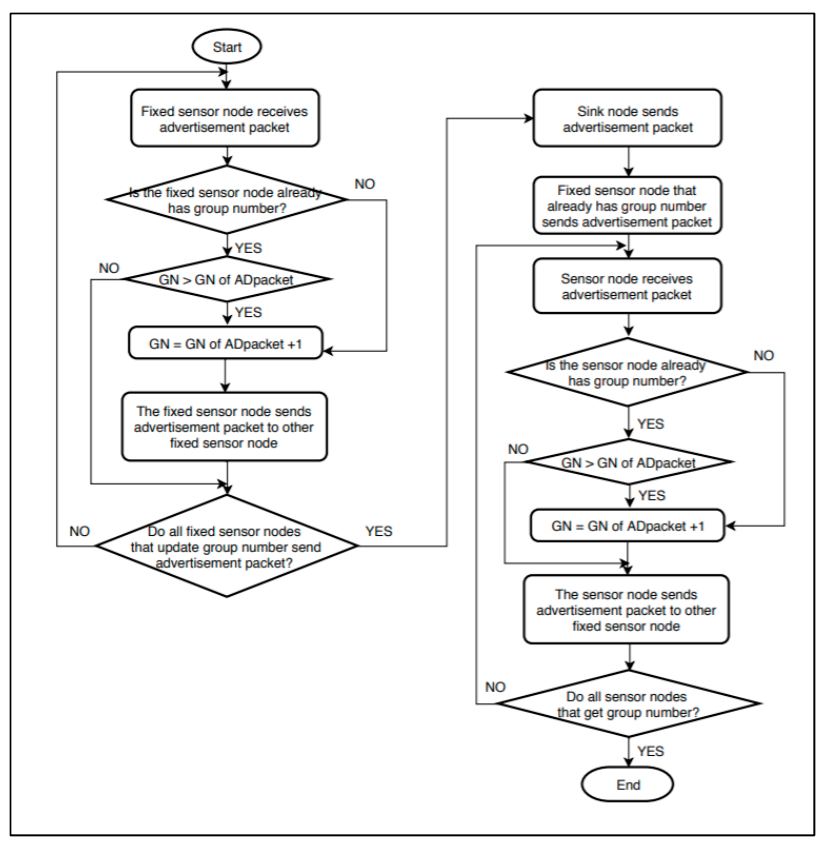
Figure 14. Initial group number setting using fixed sensor nodes.